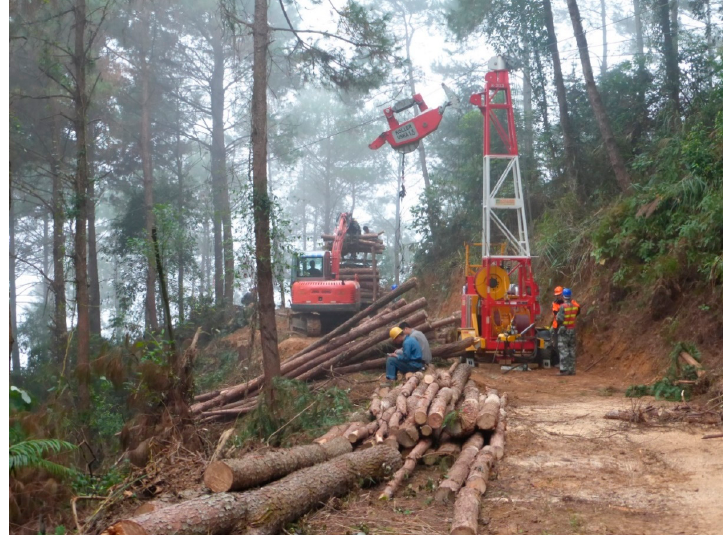
Figure 2. KOLLER K303 H tower yarder with USKA 1.5 carriage, rigged on an uphill landing (Baiyun 54) together with the JG-608 knuckle boom loader in the background, for clearing the log deck and loading logs into a timber hauling truck. Table 2. Technical Description of the KOLLER K303 H Cable Yarder.